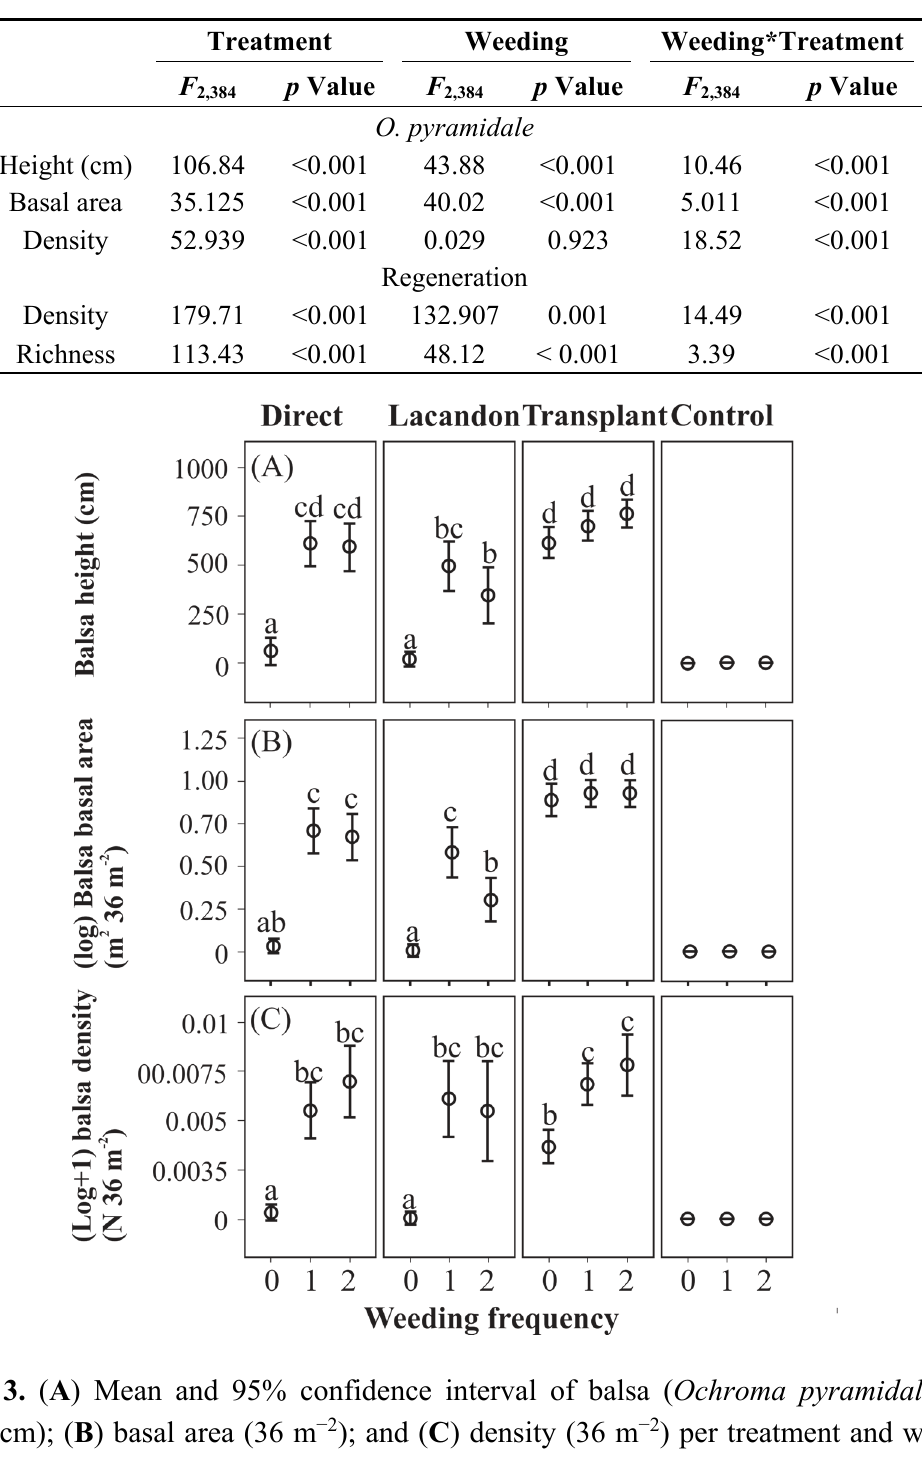
Table 1. Results of the Generalized Linear Mixed Models for the effect of the balsa treatment, weeding treatment, and the interaction between the two on balsa attributes (height, basal area, and density) and regeneration attributes (density and richness), including block as a random effect.